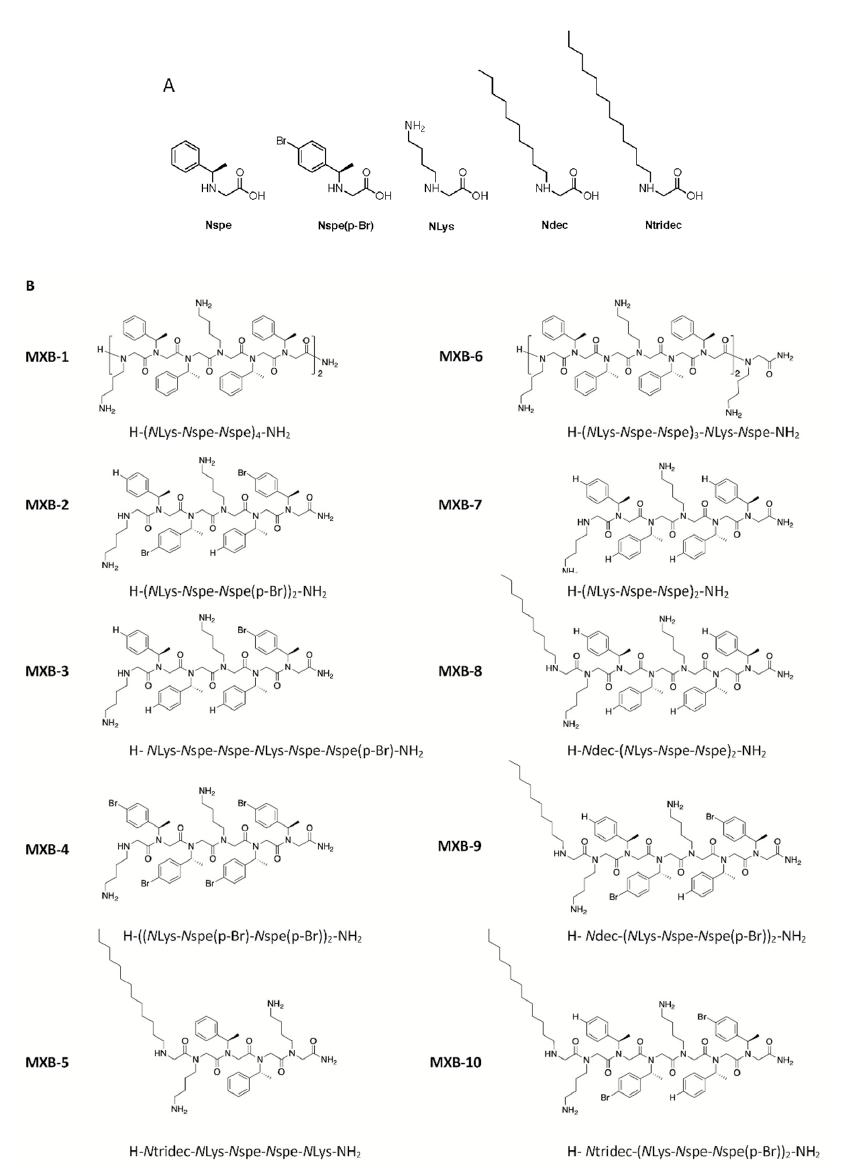
Figure 1. Structure of peptoids. ( A ) Structures of peptoid submonomers used in this library of new compounds. ( B ) Chemical structures of the ten different peptoids used in this study. Molchanova et al. found that short (6 mer), brominated analogues of Peptoid